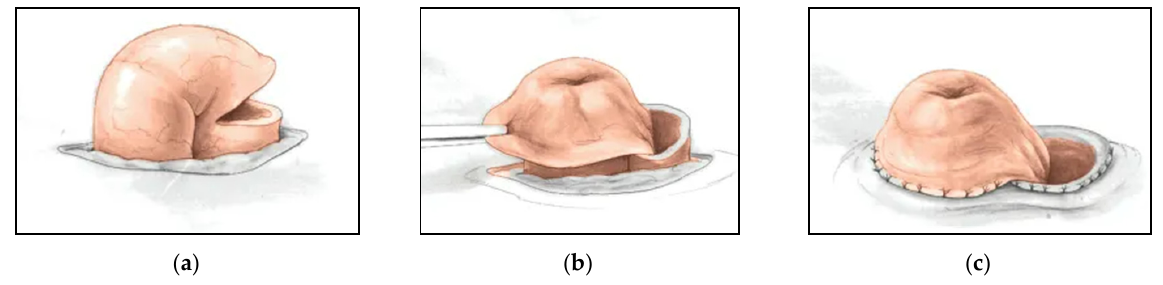
Figure 7. A Turnbull-style ostomy creation technique is demonstrated: ( a ) incision is made in the distal limb just above the skin; ( b ) Proximal limb is everted; ( c ) both limbs are sutured to the skin. Adapted from Beck et al. (2019) [39].